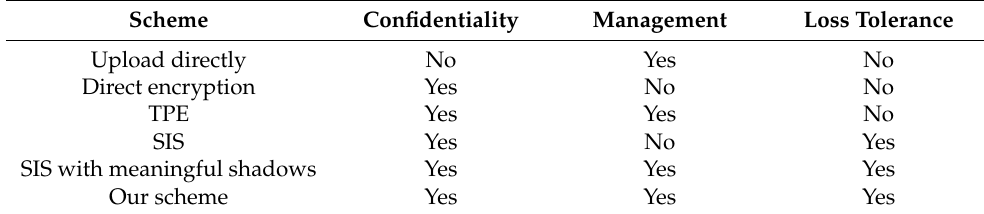
Table 3. Functional